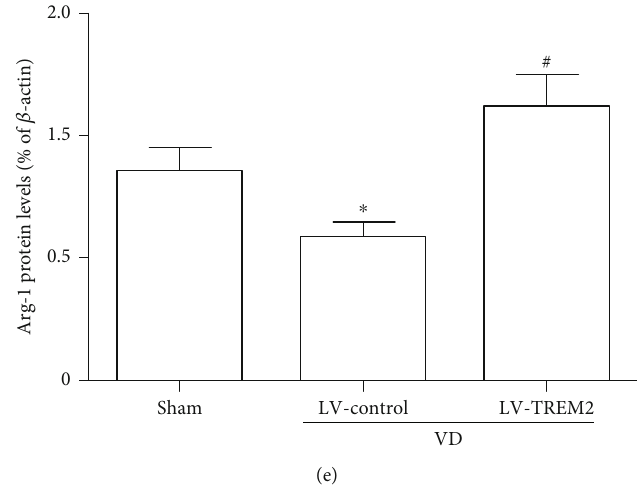
Figure 3: TREM2 overexpression modi fi es microglia phenotype in VD mice. (a) IHC staining of M1 microglia phenotype marker iNOS and M2 microglia phenotype marker Arg-1 in the hippocampus of VD mice. Scale bars = 50 μ m . (b – e) Western blot analysis of iNOS and Arg-1 protein level in the hippocampus of VD mice. Compared to the sham group, ∗ p < 0 : 05 ; compared to the LV-control group, # p < 0 : 05 .